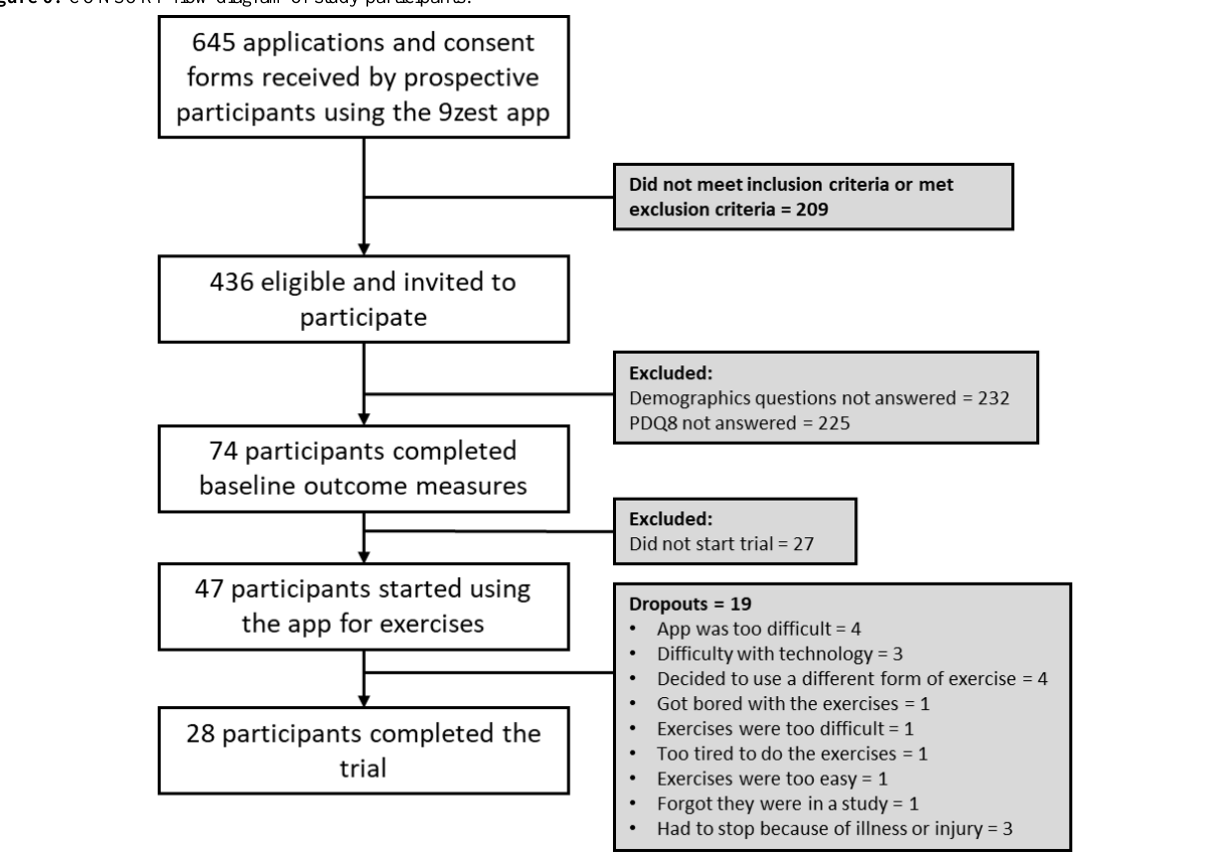
Figure 6. CONSORT flow diagram of study participants.